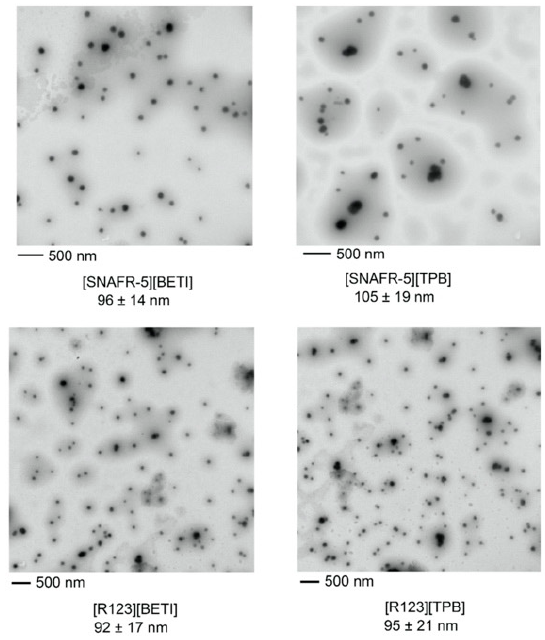
Figure 2. TEM images of R123 and SNAFR nanoGUMBOS .